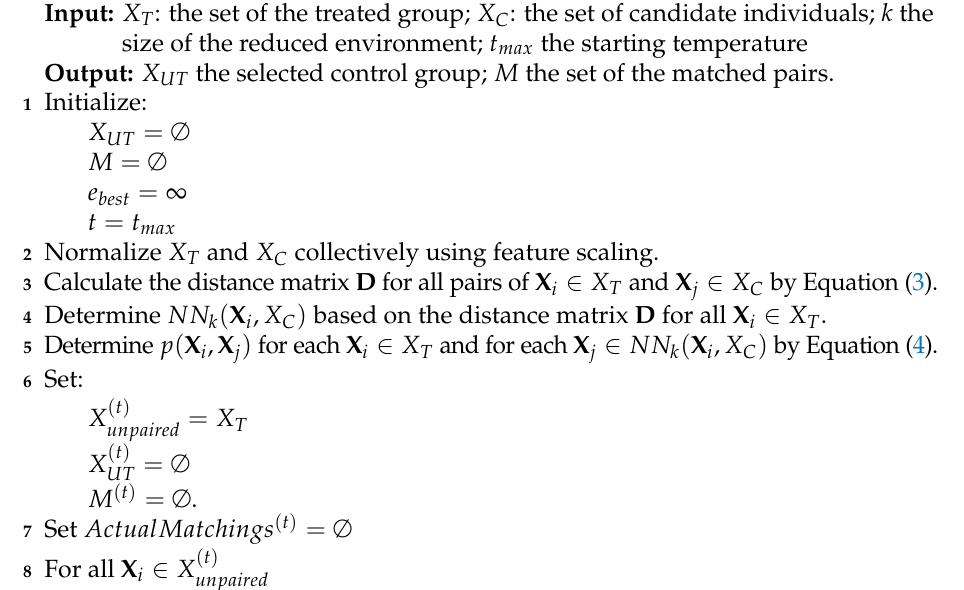
Algorithm 1: Weighted Nearest Neighbours Control Group Selection with Sim- ulated Annealing